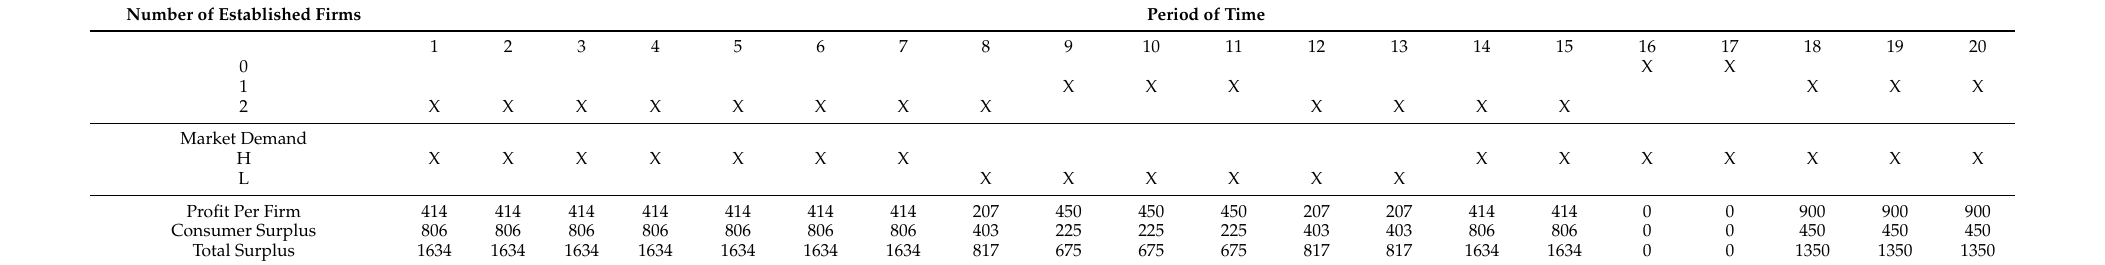
Table 9. Two active firms in the Cournot framework with the initial state of the system ( 2, H )